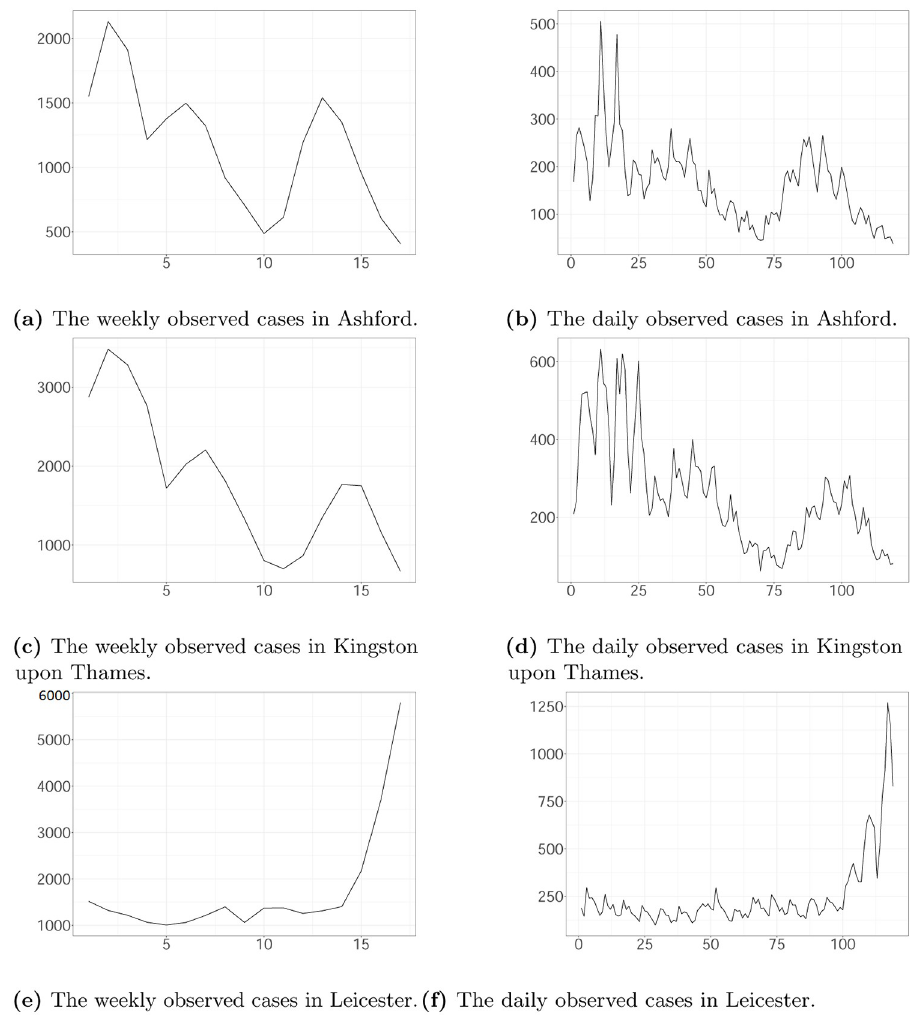
Fig 6. The daily and weekly observed infections in local authorities plotted against time. (a) The weekly observed cases in Ashford. (b) The daily observed cases in Ashford. (c) The weekly observed cases in Kingston upon Thames. (d) The daily observed cases in Kingston upon Thames. (e) The weekly observed cases in Leicester. (f) The daily observed cases in Leicester.